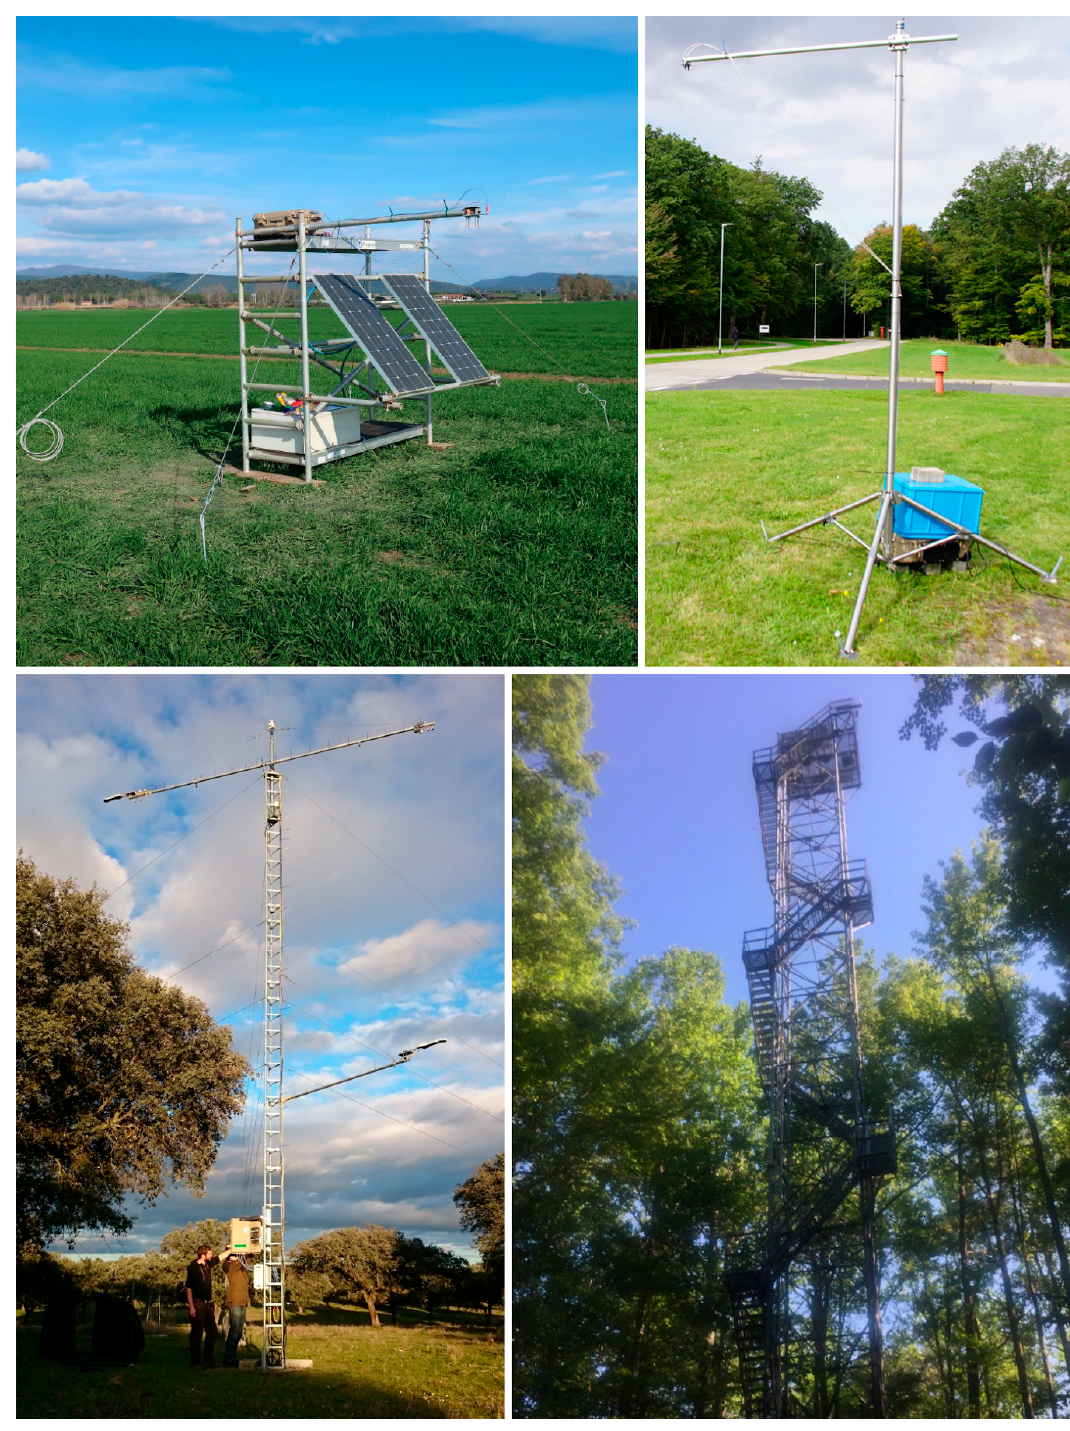
Figure 4. Different ground-based F measurement setups in Grosseto, Italy (top left); Juelich, Germany (top, right); Majadas, Spain (bottom, left); and Washington, DC, USA (bottom, right).